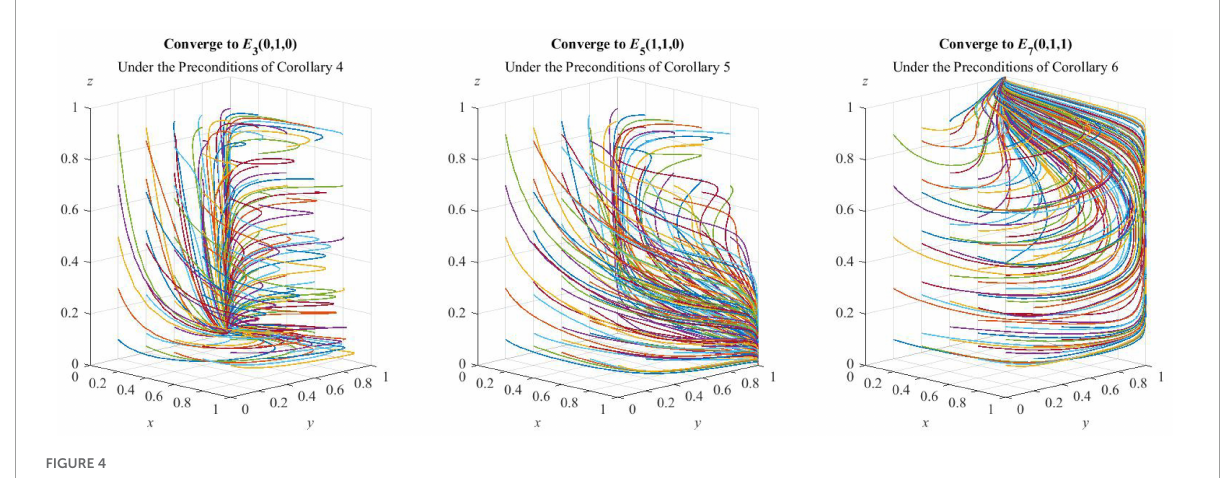
FIGURE4 Simulation verification of the ESS.